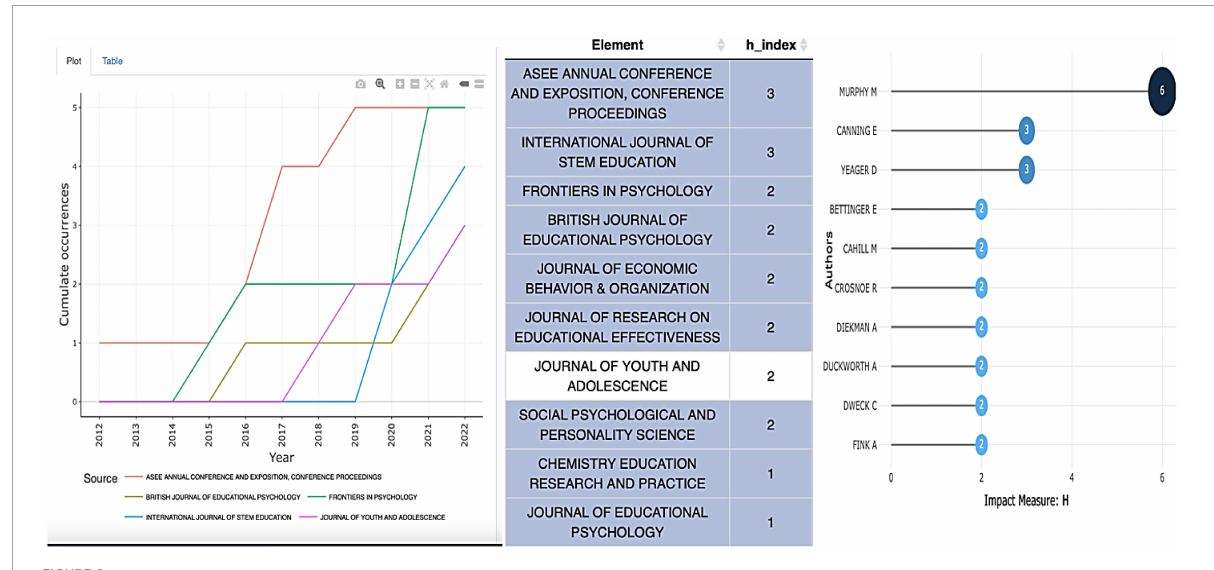
FIGURE6 Relationships between authors, publication sources, and h